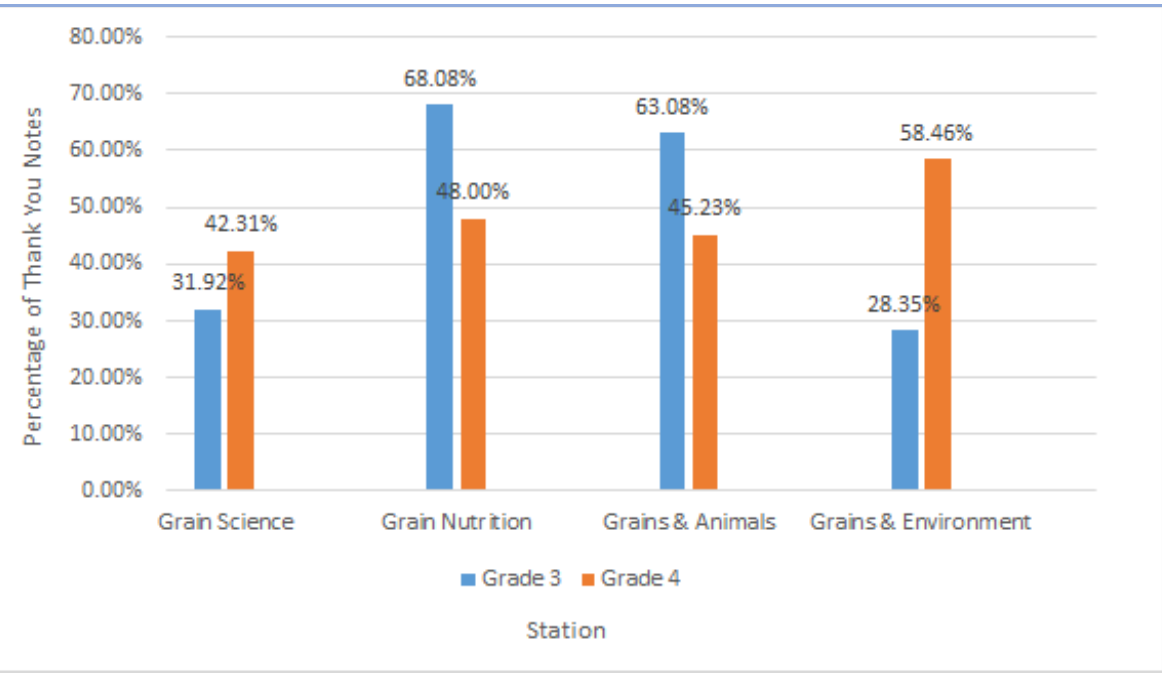
Figure 3. Percentage of Student Thank-You Note Responses Mentioning Each Station (via Drawing and/or Writing) By Grade